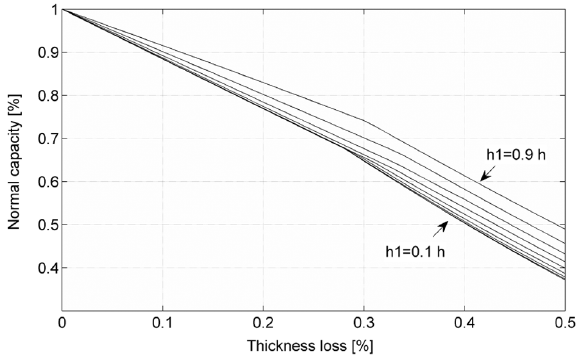
Fig. 5. A sensitivity analysis on the corrosion height h